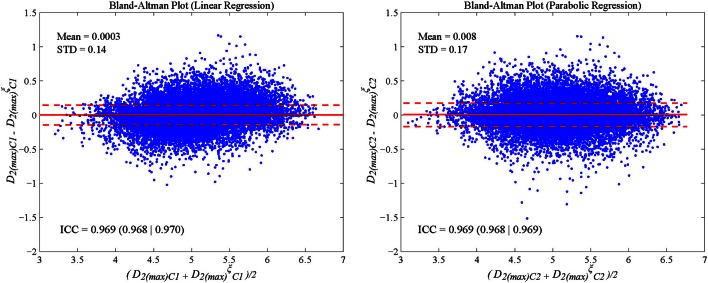
Bland-Altman plots and intra-class coefficient (ICC) illustrate the agreement between subject-specific and median correction approaches computed on Fantasia database to correct HR effect for both proposed regressions for corrected D2(max) index: linear (left panel) and parabolic (right panel).